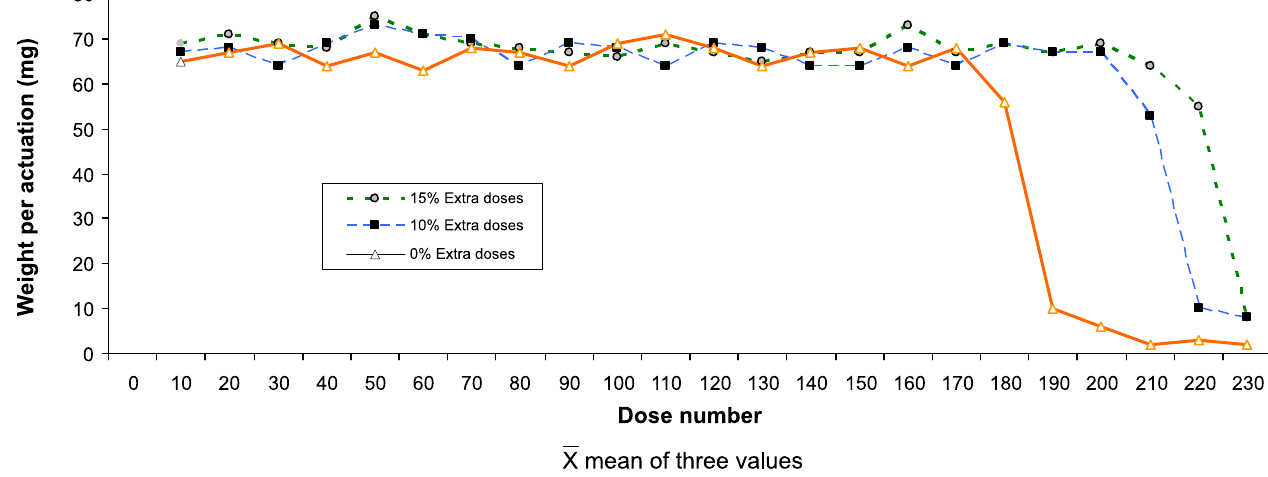
FIGURE 2 - Effect of extra dose on valve delivery from beclomethasone dipropionate MDI containing 200